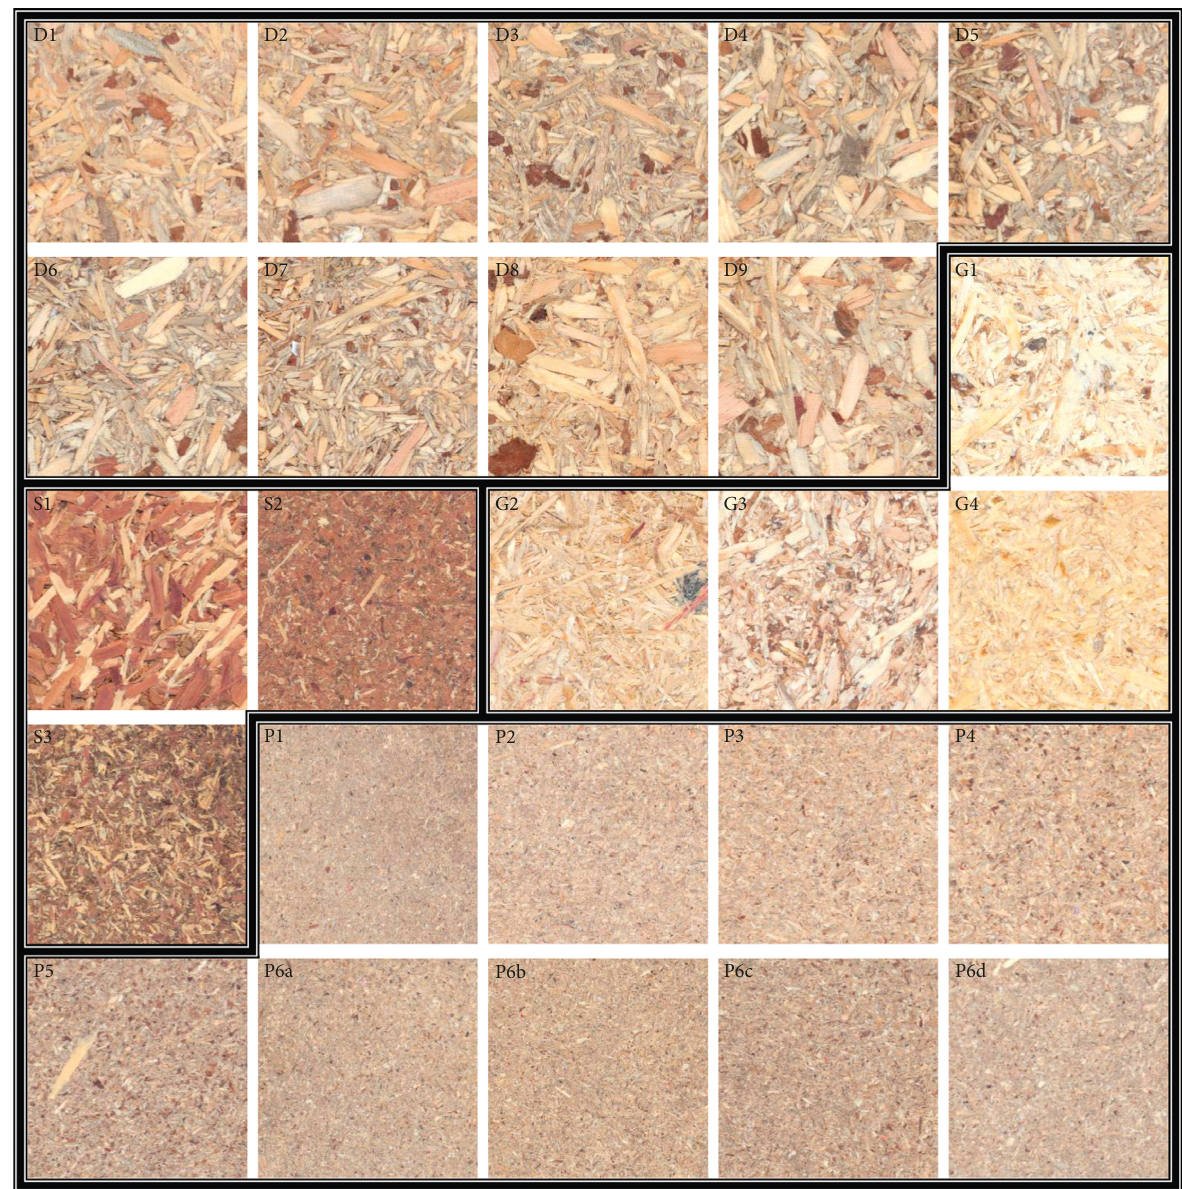
Figure 1: Appearance of particleboard surfaces representing 25 investigated Figure 3. It consists of five chemometric models imple- mented at two discrimination levels. Model #1 is used to screen the unknown spectrum and determine the most probable class corresponding to the particleboard type.